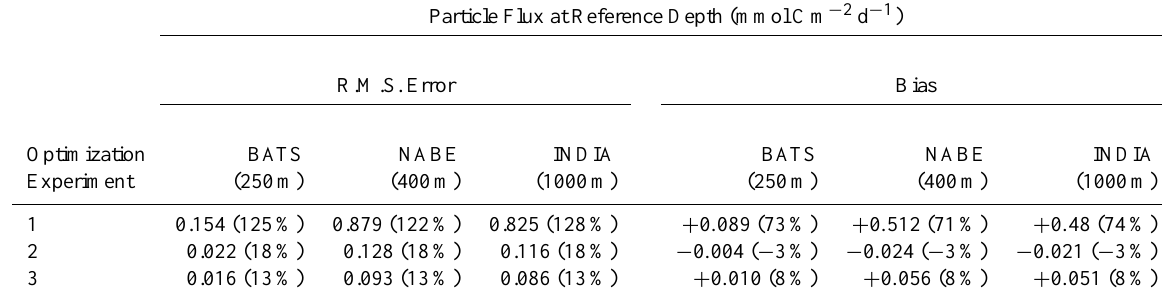
Table 7. Error in annual mean sinking particle